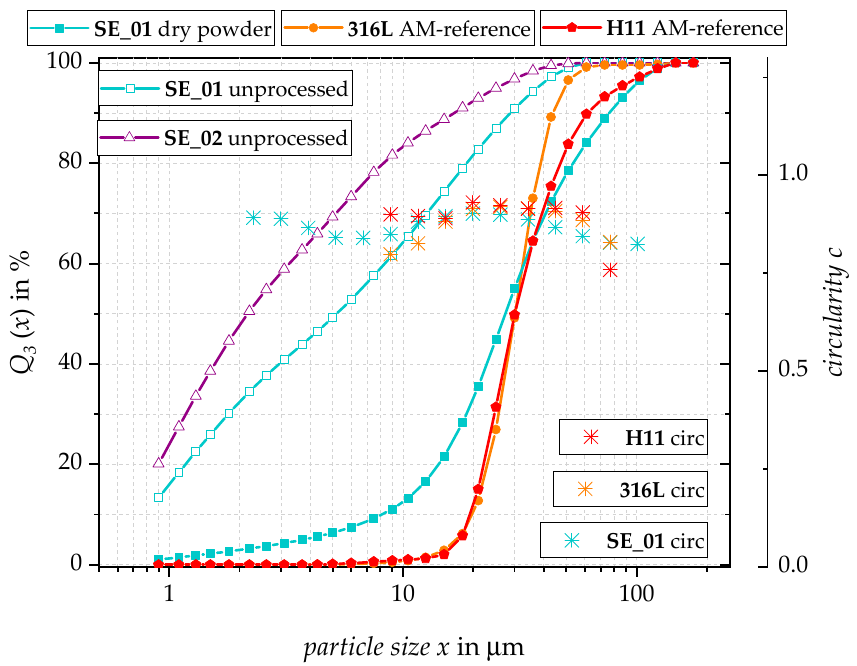
Figure 6. Particle size distributions of unprocessed sludges SE_01-MT and SE_02-AP, processed and dry particles of SE_01-MT as well as commercial AM powder 316L/1.4404 and H11/1.2343.